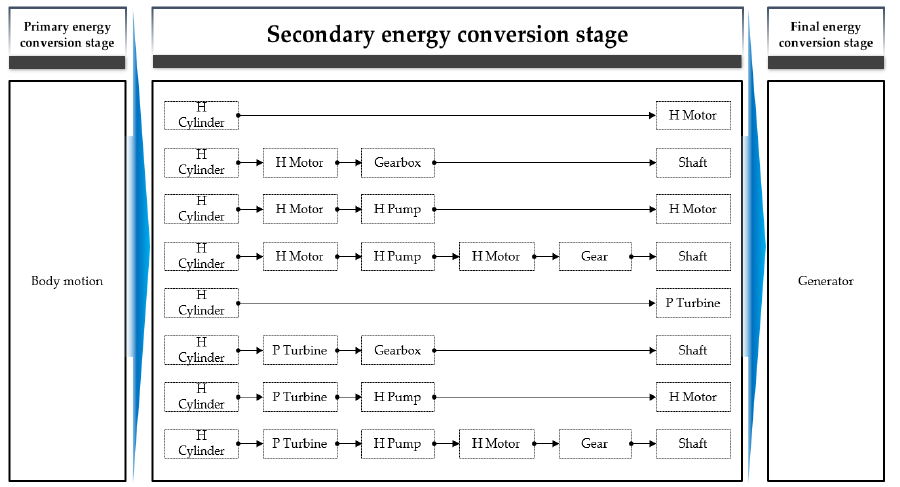
Figure 6. PFD of secondary energy conversion system started with the hydraulic